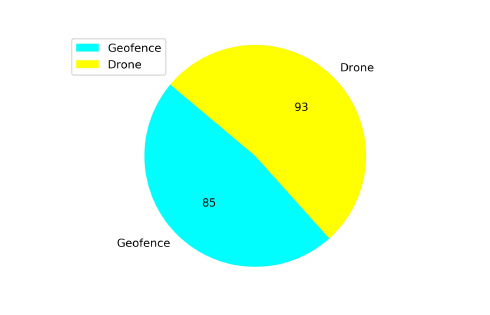
Figure 23. Crash report chart for Case 1.2, Annealing at 10K steps.